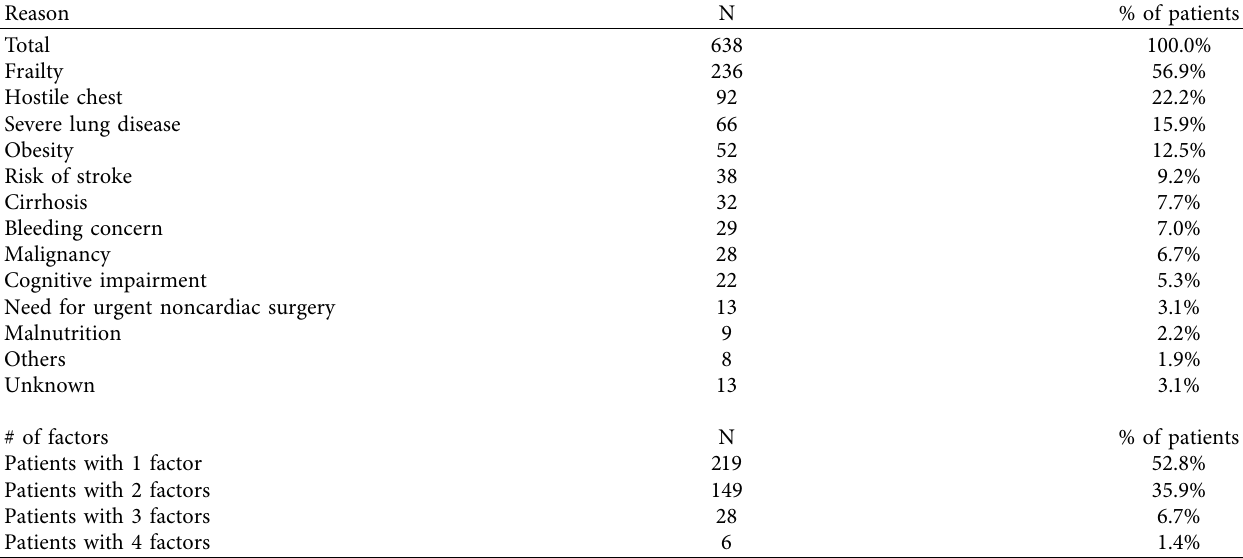
Table 2: Reasons for recommending transcatheter aortic valve replacement surgery for patients with STS PROM ≤ 3%.